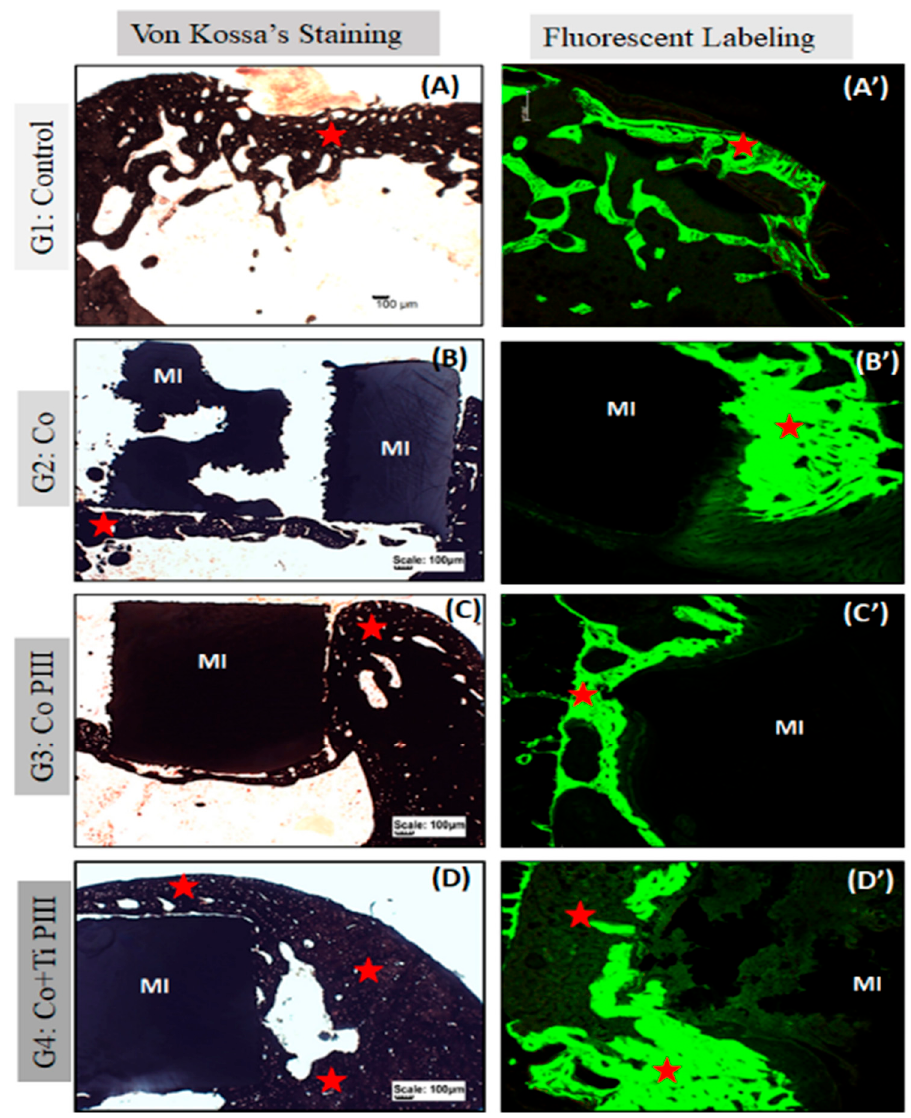
Figure 6. Evaluation of histologic features of defects in the rat femur bone, Von Kossa’s